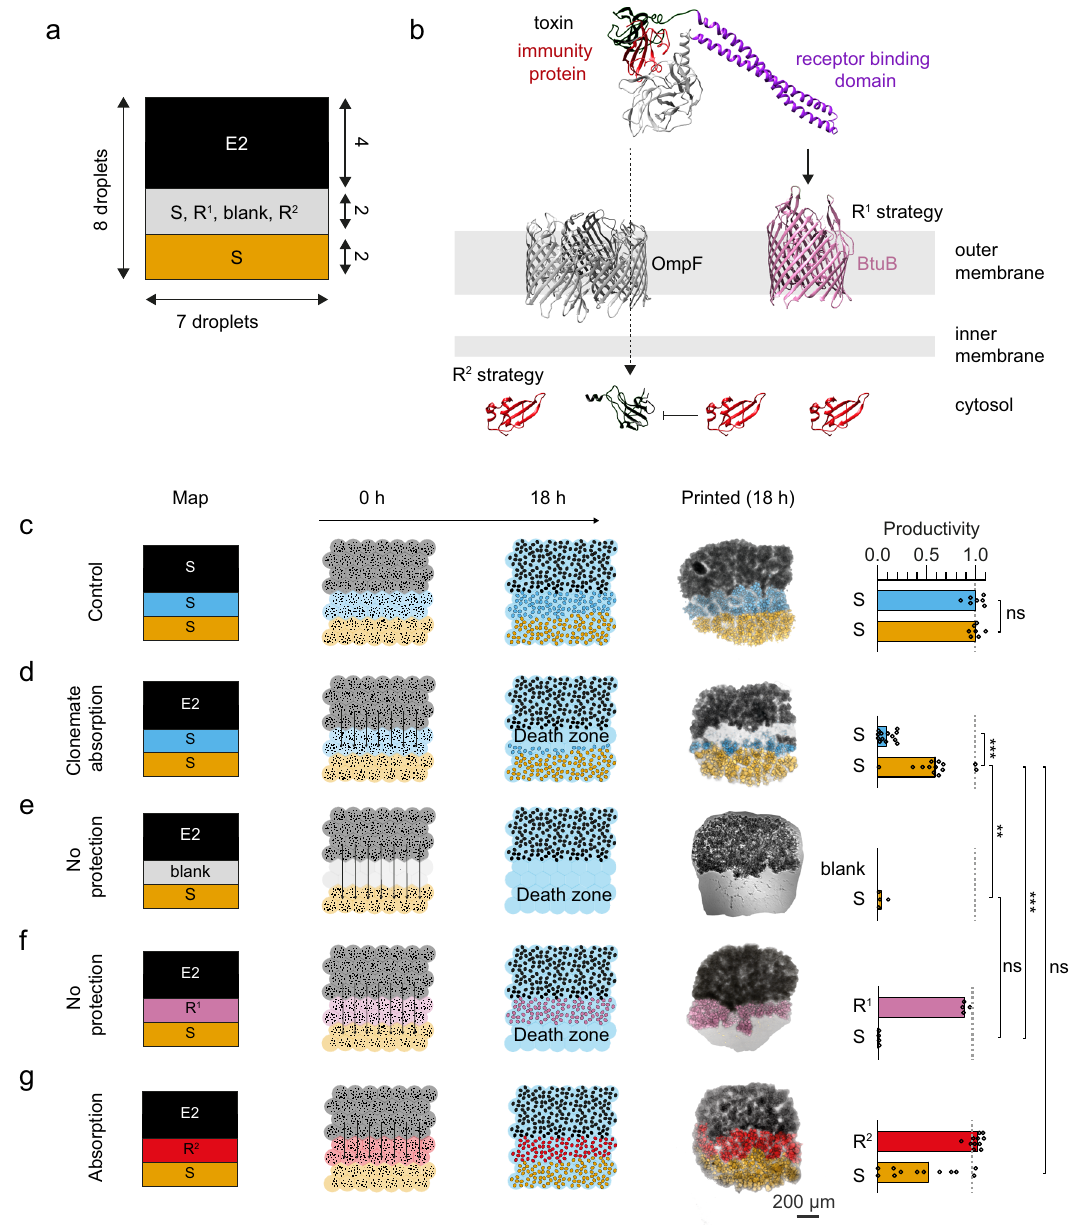
Fig. 4 Susceptible cells protect clonemates by binding incoming toxin. a Schematic of the printing map used for testing clonemate absorption. The producer strip (E2) consists of 7 × 4 × 1 droplets (black), the changeable strip consists of 7× 2 × 1 droplet (grey) and the sensitive strip consists of 7× 2 × 1 droplets (orange) in the x , y and z dimensions, respectively. b A schematic of the two resistance strategies used for creating R 1 and R 2 . R 1 is resistant to colicins because of deletion of the BtuB receptor (which normally binds colicins). R 2 is resistant to colicins through constitutive expression of the